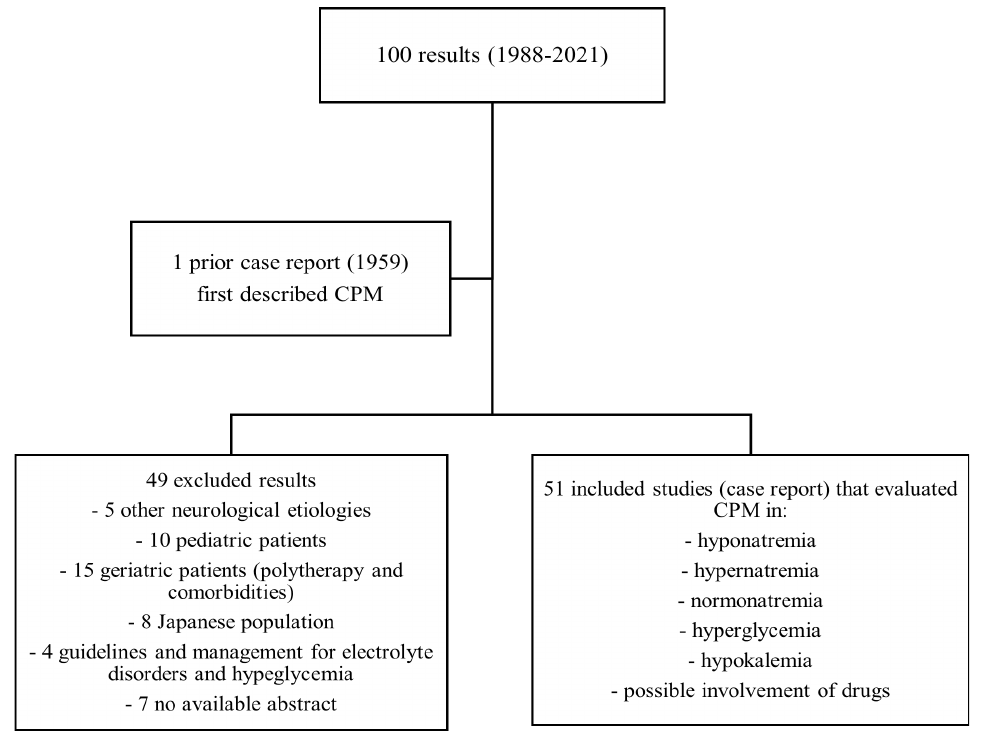
Figure 3. Strategy research in the systematic revie